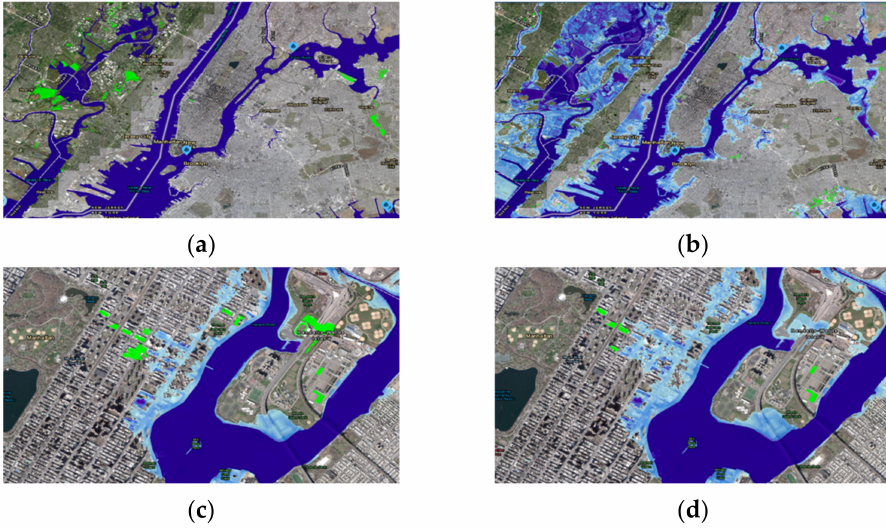
Figure 11. Light blue regions indicate areas of sea-level inundation. ( a ) New York City and vicinity with sea level in 2021; ( b ) and the extent of extreme flooding due to sea-level rise by 2100; ( c ) show significant flooding pictured in the Central Park region of Manhattan, New York by 2050 and ( d )